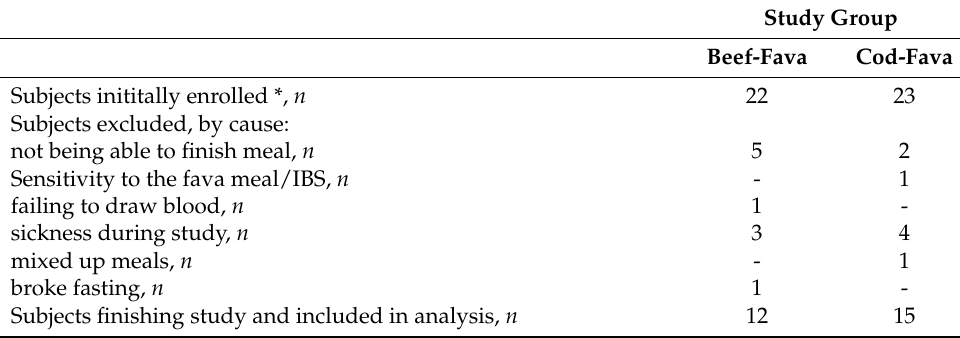
Table 1. Exclusion and final inclusion of participants.